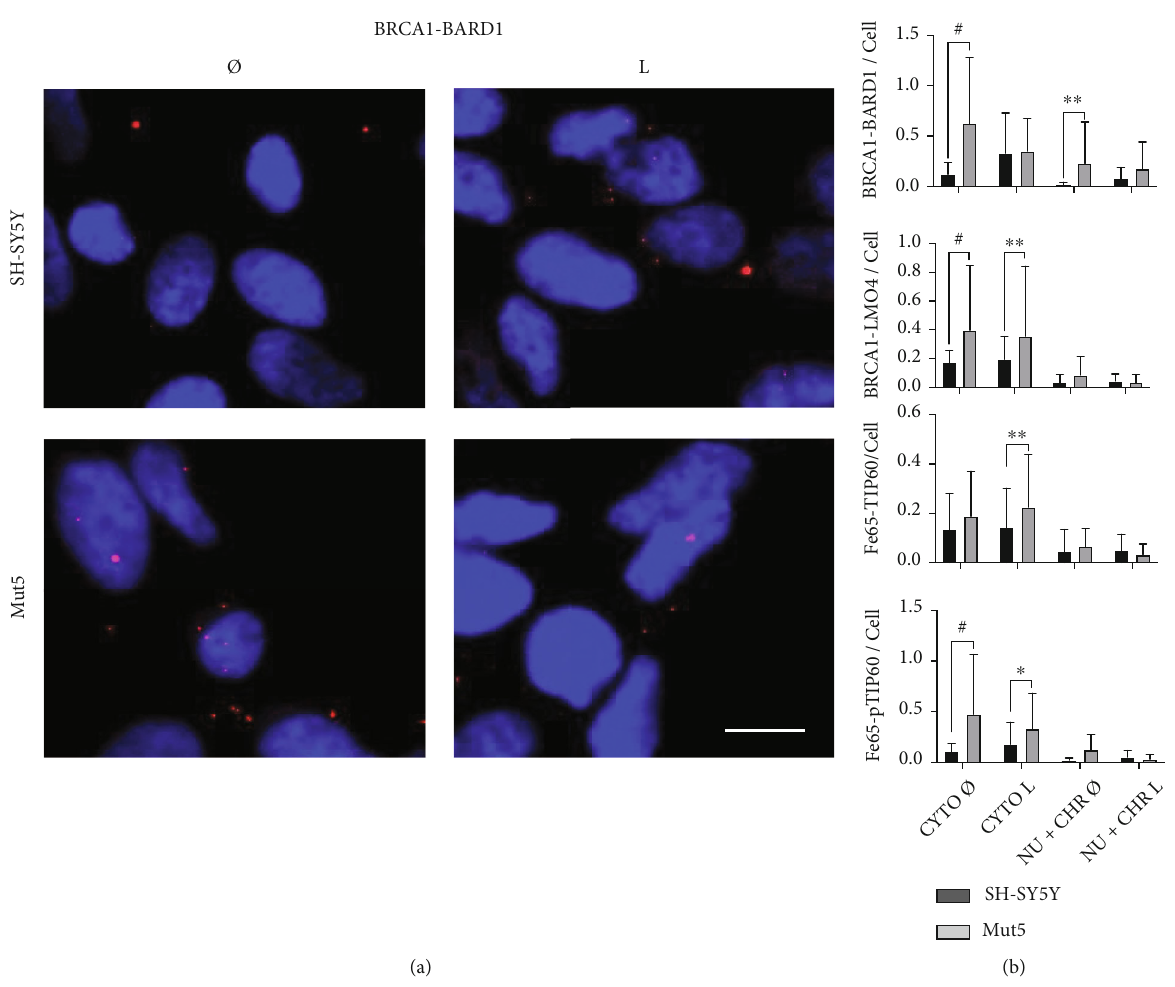
Figure 8: In situ proximity ligation assay with the SH-SY5Y and Mut5 cells treated, or not, with leptomycin B (L). In (a), representative pictures of BRCA1-BARD1 heterodimers (red dots) showing higher numbers in the cytoplasm and the nuclei (DAPI staining) of the Mut5 cells compared to the wild-type cells. Scale bar: 75 μ M. In (b), graphical representation of the statistical analyses of the experiment for BRCA1-BARD1 heterodimers ( n = 9 ). The data analyses for the other heterodimers, BRCA1-LMO4, Fe65-Tip60, and Fe65-pTip60, are also shown ( n = 9 ). We observed statistically signi fi cant di ff erences (ANOVA with Sidak ’ s multiple comparison test: ∗ p < 0 : 05 ; ∗∗ p ≤ 0 : 002 ; # p ≤ 0 : 0002 ) between both strains in the cytoplasm (CYTO), not in the cell nuclei. The nuclei are labelled NU+CHR according to the denomination used for the Western blots (NU: nucleoplasm; CHR: